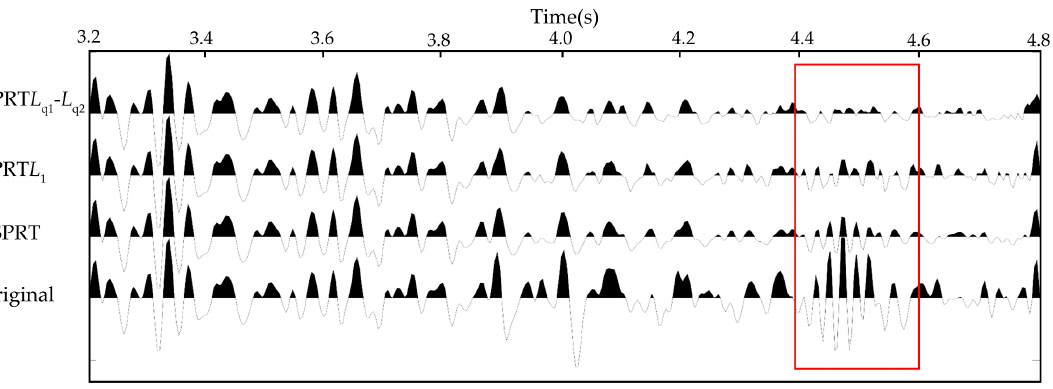
Figure 9. Comparison of single trace amplitude after multiple attenuation by three algorithms. The red rectangle indicate that the amplitude of multiple decays more significantly in the proposed